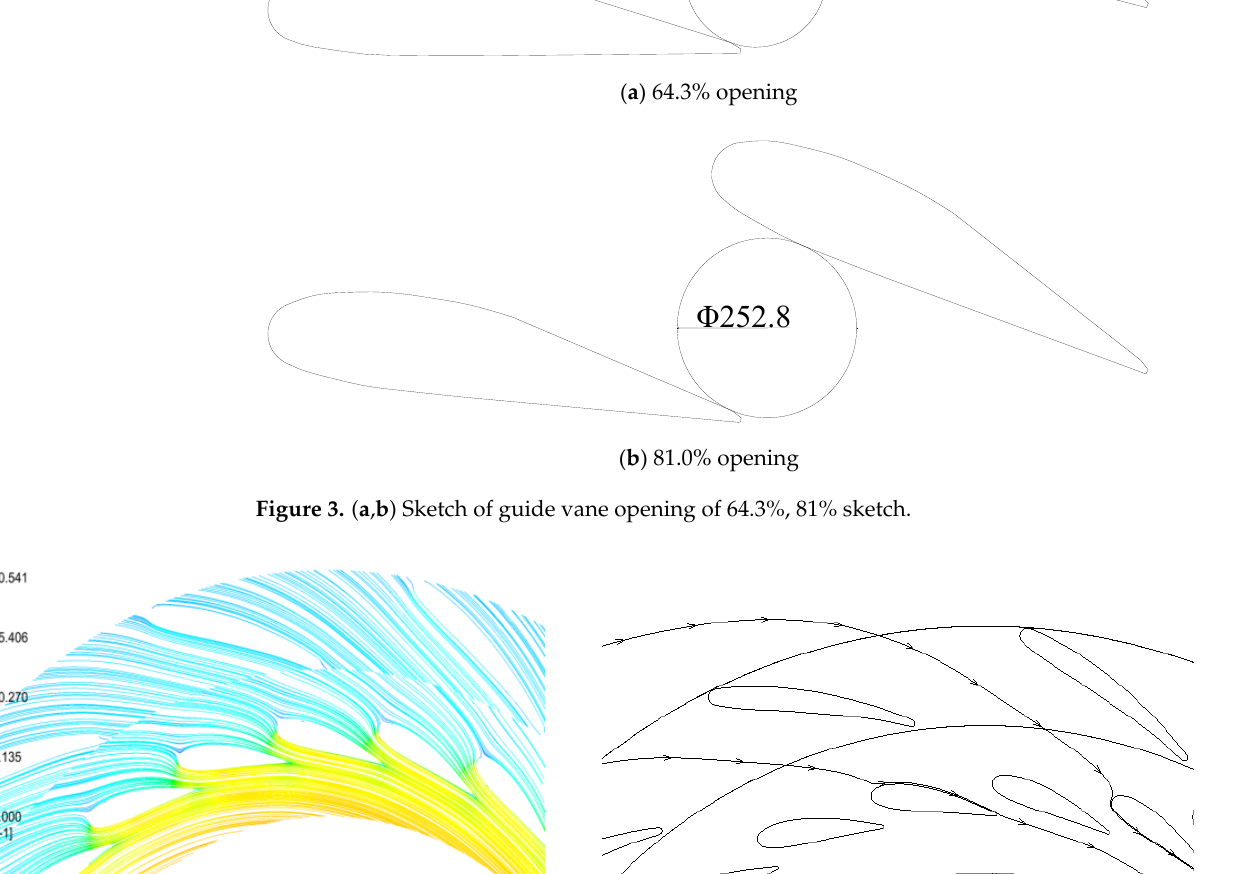
Figure 4. Schematic diagram of runner extraction.